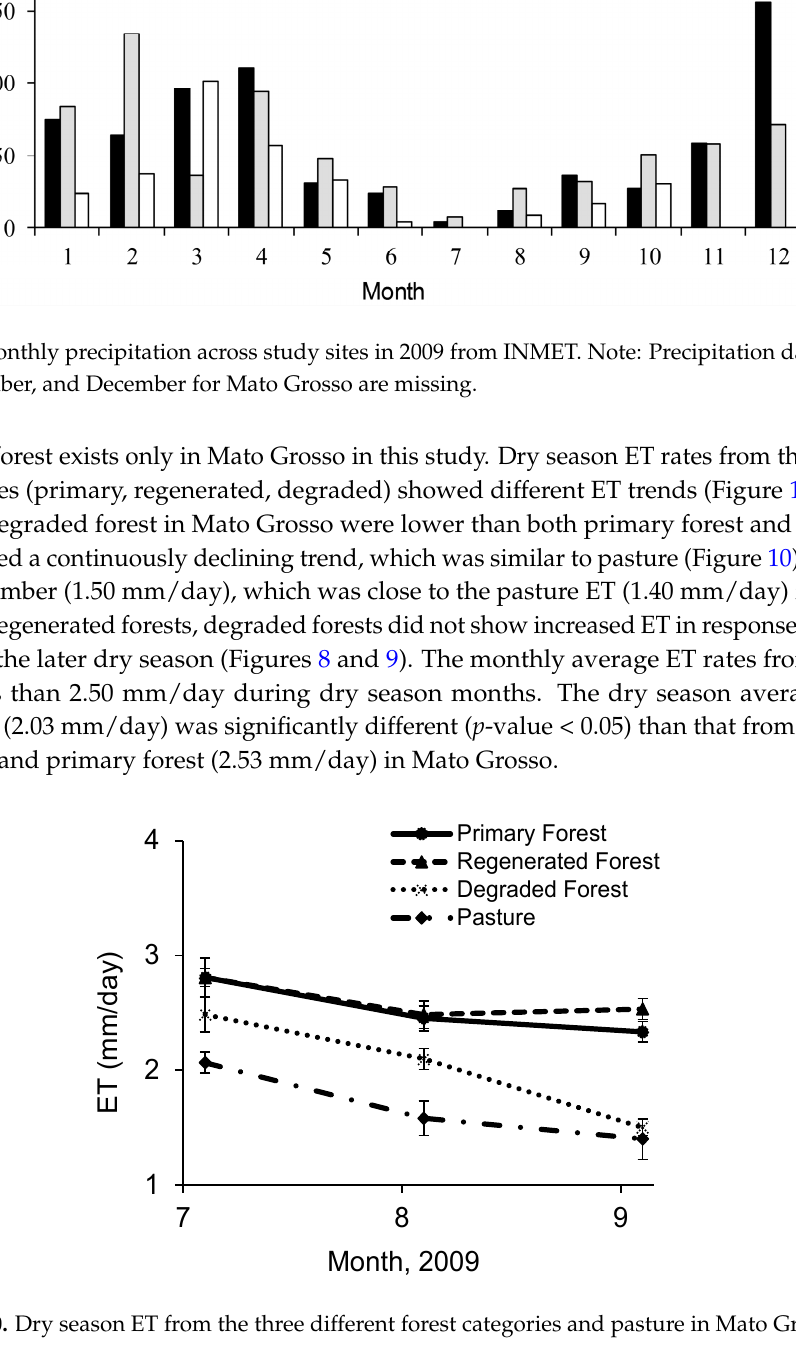
Figure 10. Dry season ET from the three different forest categories and pasture in Mato Grosso.